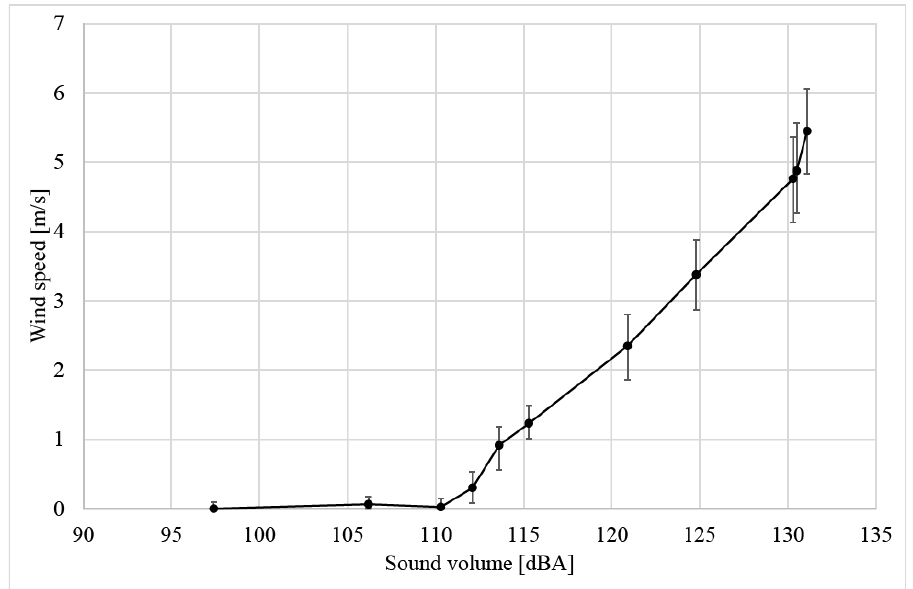
Figure 4. Relationship between sound volume and wind speed.